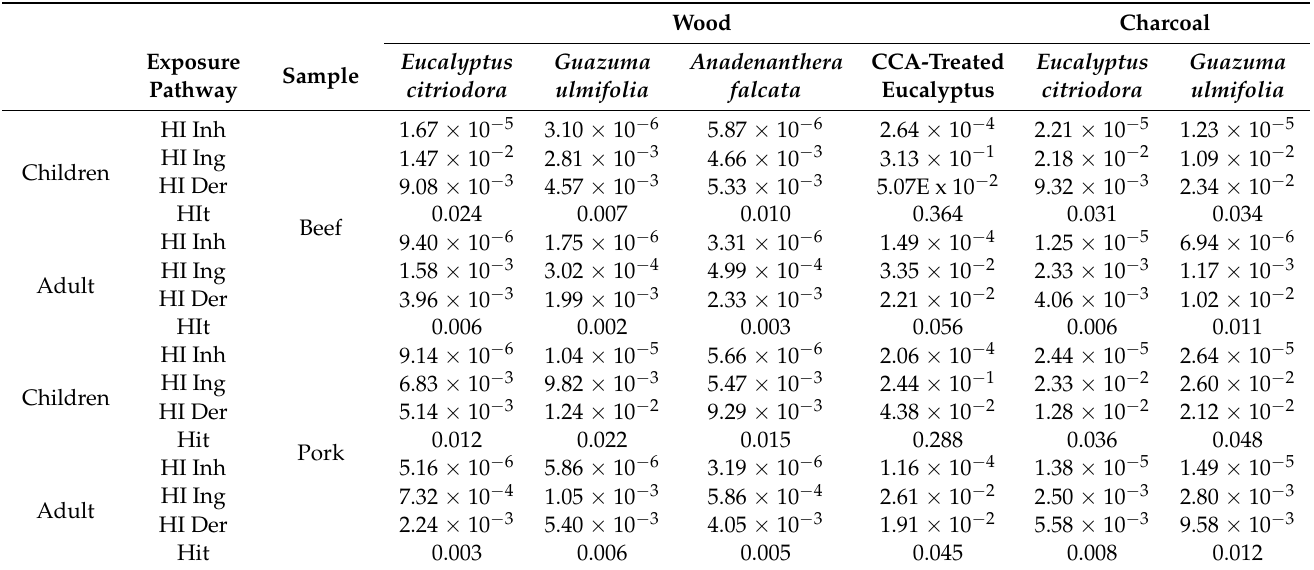
Table 5. HI values for non-carcinogenic risks and HIt (integrated per exposure pathway and total aggregate).